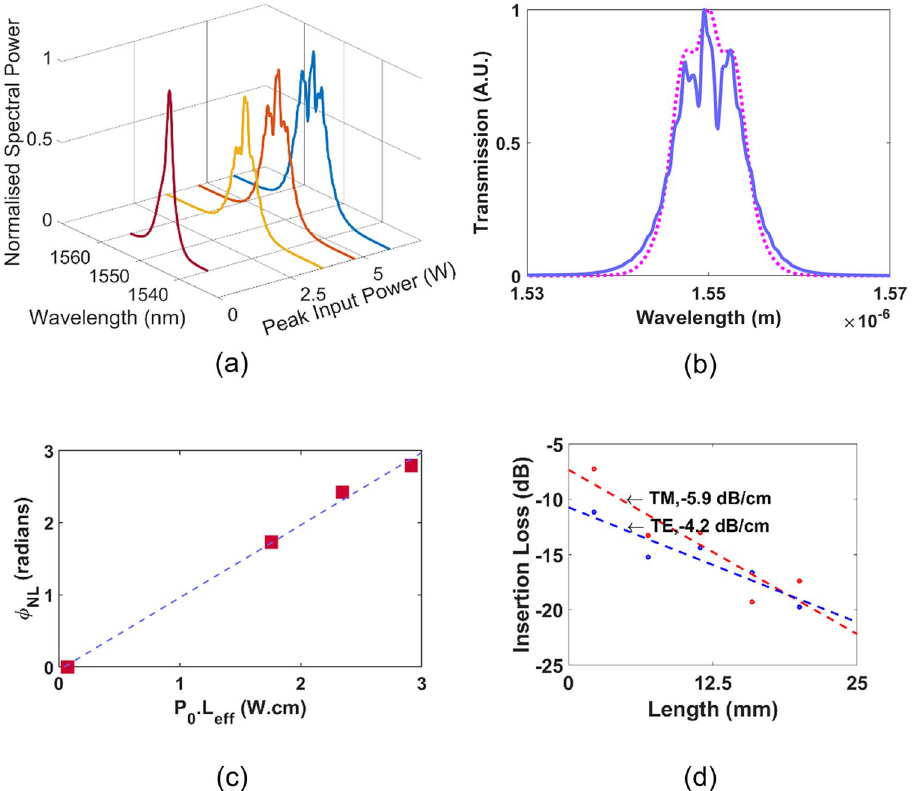
Figure 5. ( a ) SPM spectrum plots for peak input powers 3.6 W ( — ), 4.7 W ( — ), 5.9 W ( — ), and Source ( — ) ( b ) Modelled ( ) and experimentally measured ( — ) SPM spectra for P 0 = 5.9 W. ( c ) Parameter fit for experimental data (red filled square) and fitted line ( -- ). ( d ) Cutback measurements for the waveguide used for the SPM measurements, for both the TE (blue filled circle) and TM mode (red filled